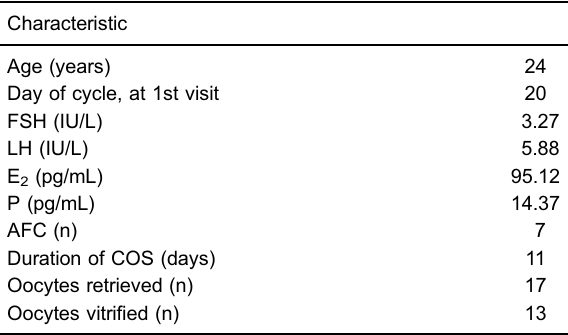
Table 1. Characteristics and controlled ovarian stimulation (COS) outcomes of a patient with myelodysplastic syndrome undergoing emergency fertility